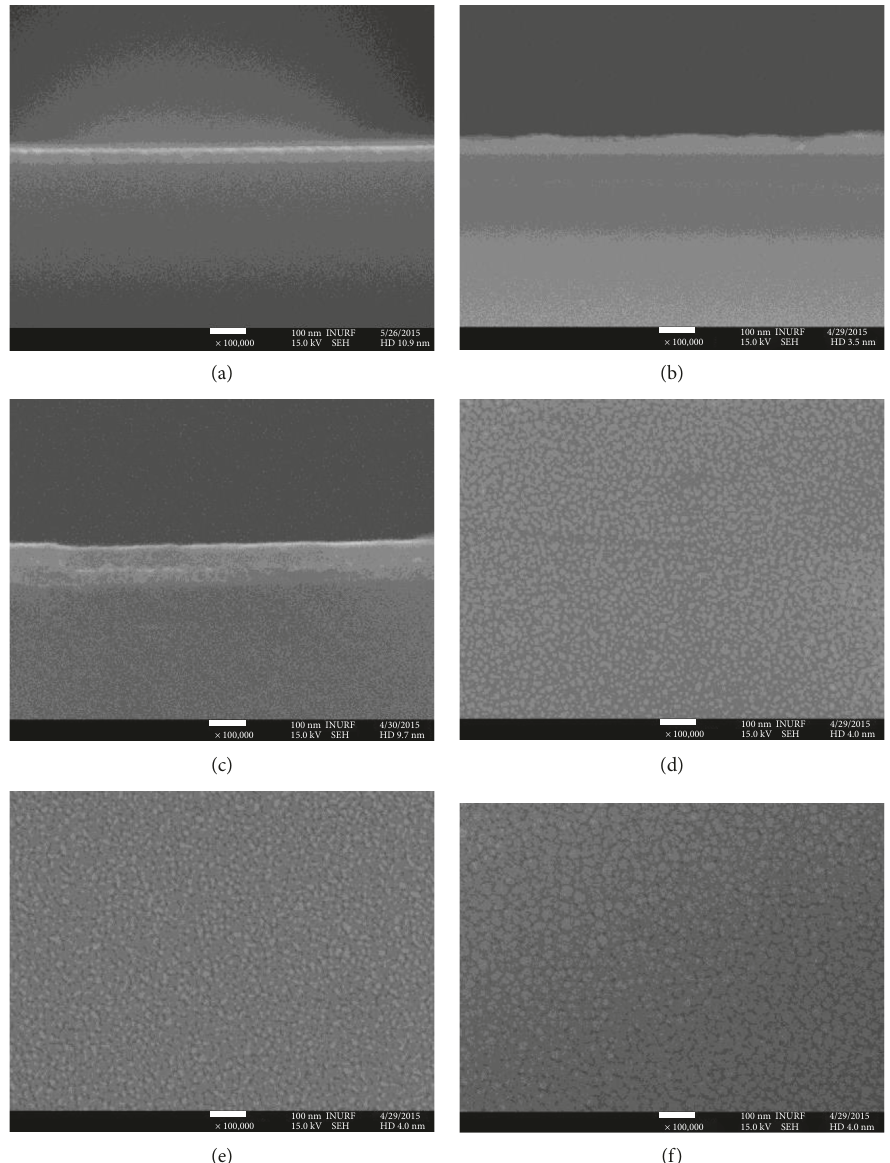
Figure 2: Cross-sectional FE-SEM images of (a) AZO, (b) Ag/AZO, and (c) ITO/Ag/AZO. Top view FE-SEM images of (a) AZO, (b) Ag/AZO, and (c)